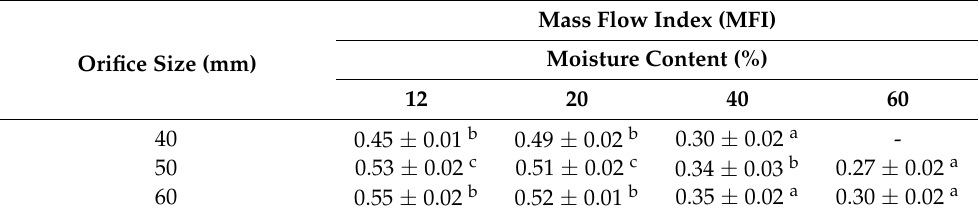
Table 5. Mass flow index (MFI) values of soybeans with various moisture content during discharging from the silo with various orifice sizes.